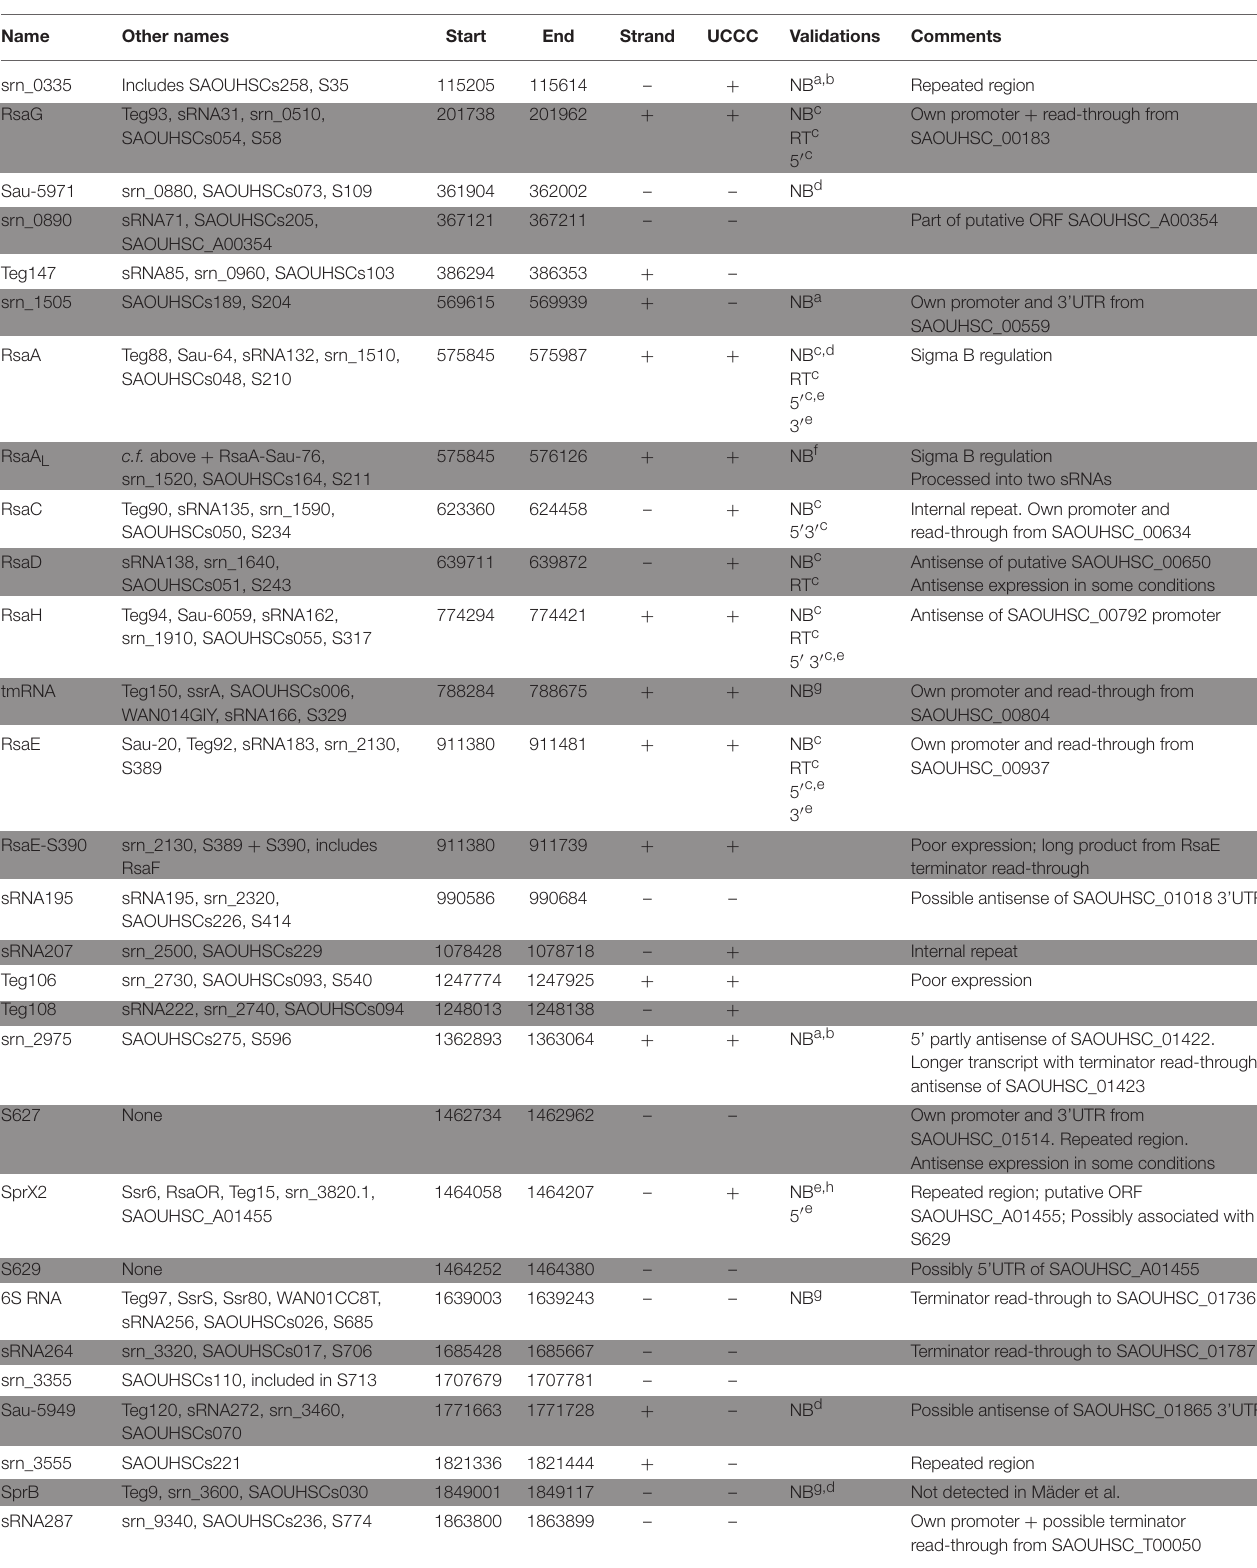
TABLE 1 | Bona fide sRNAs expressed in